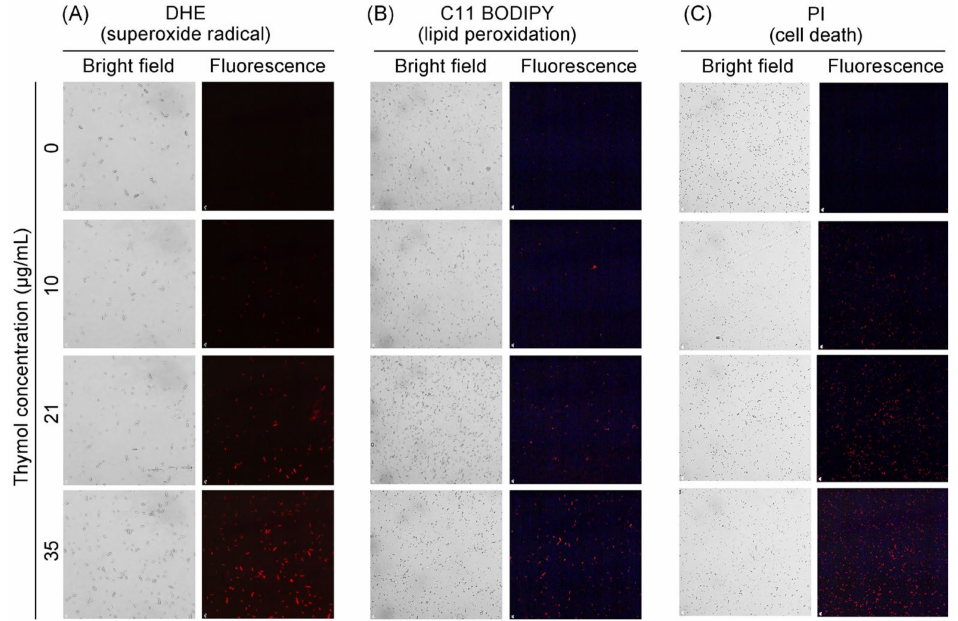
Figure 9. The effect of thymol on superoxide radical, lipid peroxidation, and cell death in the conidia of FON . The conidia were treated with thymol (0, 10, 21, and 35 µ g/mL) for 24 h. Then the conidia were collected for ( A ) DHE-based detection of superoxide radical, ( B ) C11 BODIPY-based detection of lipid peroxidation, and ( C ) PI-based detection of cell